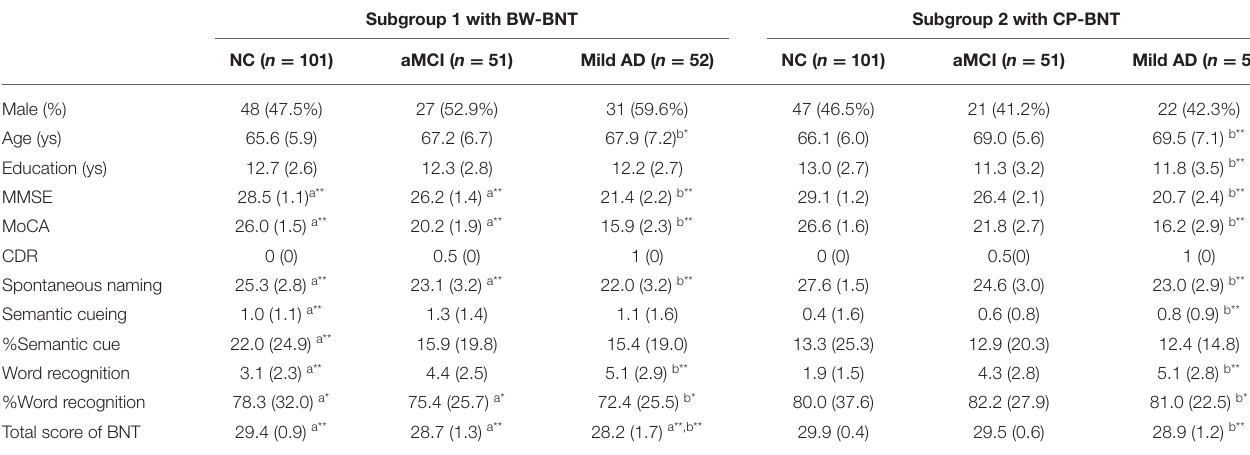
TABLE 1 | Demographic, cognitive characteristics, and performance of BNT in the two subgroups. Subgroup 1 with